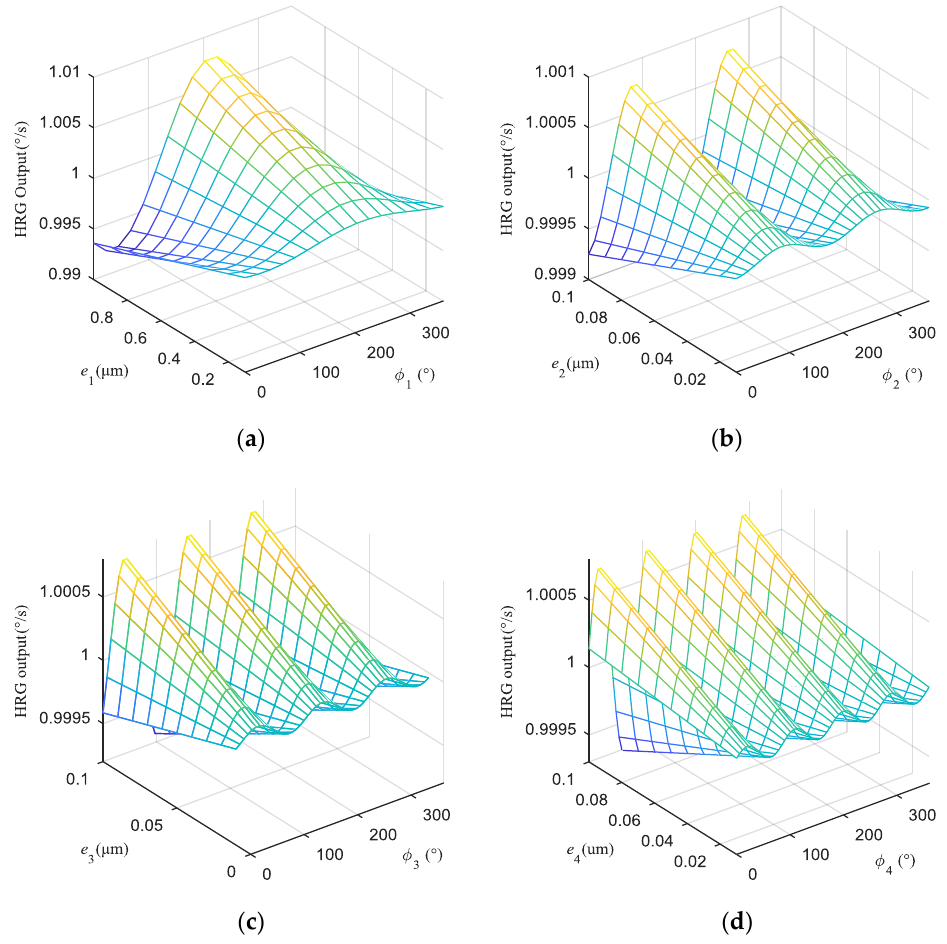
Figure 7. The output errors caused by the first four harmonics of uneven capacitance gap under 1°/s are respectively: ( a ) Output error caused by the first harmonic; ( b ) Output error caused by the second harmonic; ( c ) Output error caused by the third harmonic; ( d ) Output error caused by the fourth harmonic.